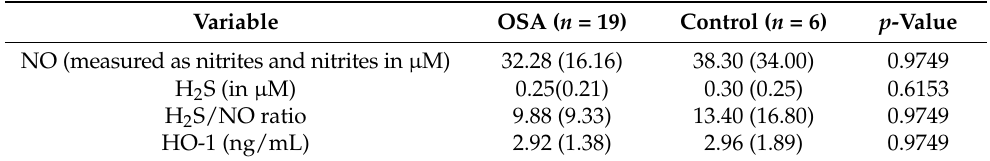
Table 2. Baseline levels of the gasotransmitters and HO-1 in samples collected prior to sleep. All data are represented as mean (SE).